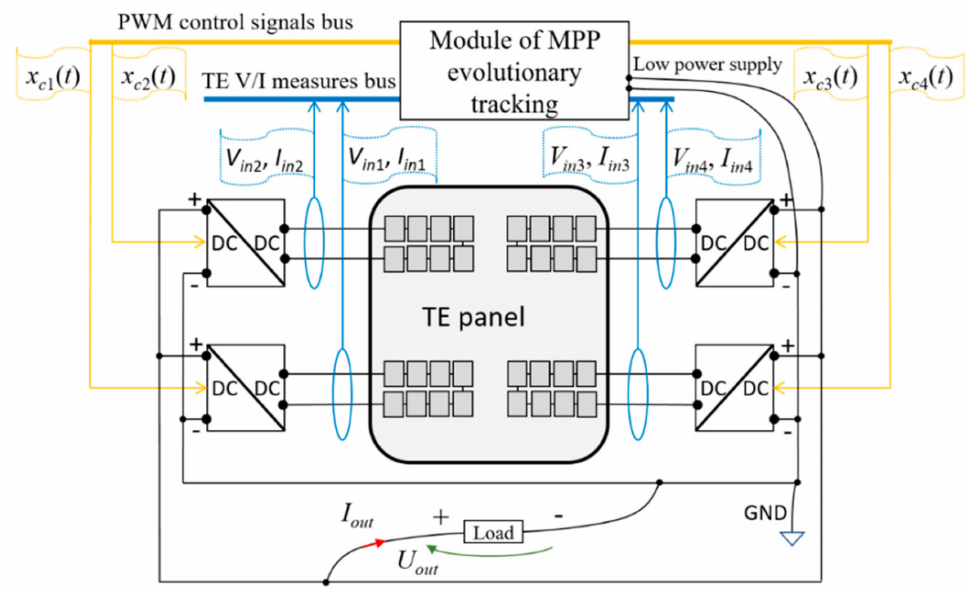
Figure 2. TE panel with the individual mini-converter in each